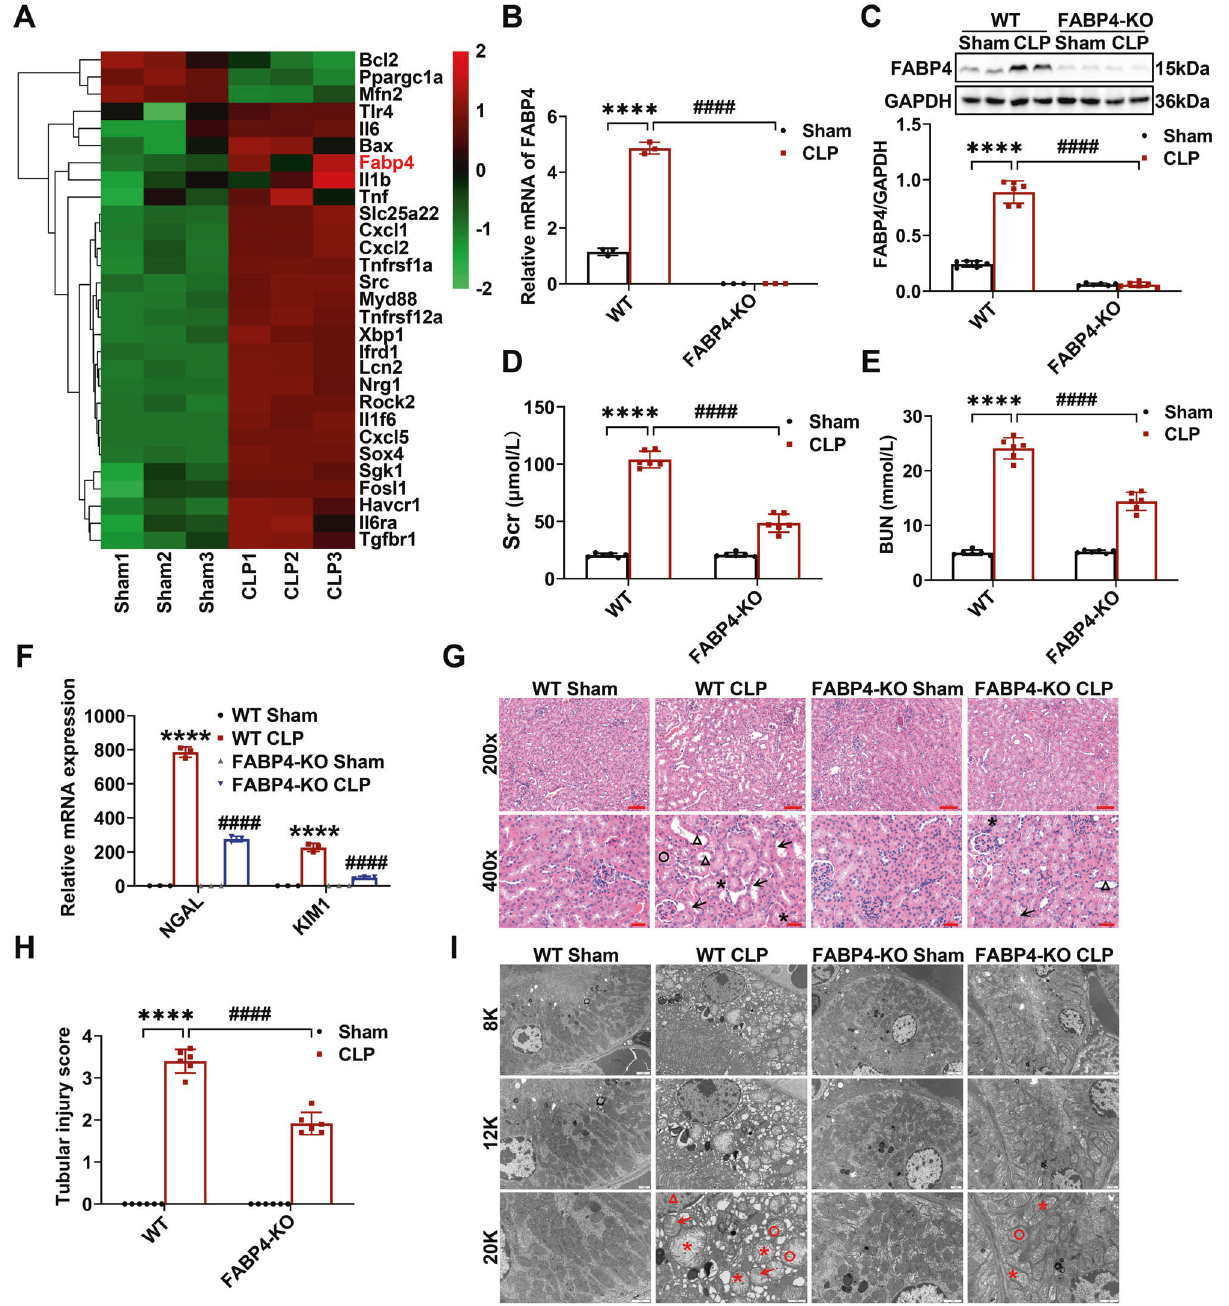
Fig. 1 FABP4 de fi ciency ameliorated CLP-induced septic AKI in mice. C57BL/6J, FABP4 KO, and WT mice (male, 8 – 10 weeks old) were subjected to CLP or sham surgery and killed 16 h later. A Representative heatmap of differentially expressed genes in the kidneys of C57BL/6J mice between sham and CLP group ( n = 3). B Quantitative real-time PCR analysis of FABP4 in kidney tissues ( n = 3). C Western blotting of FABP4 and quanti fi cation by densitometry normalized with GAPDH in the kidneys ( n = 6). D Serum creatinine (Scr) and ( E ) BUN in different groups of mice ( n = 6). F Quantitative real-time PCR analysis of NGAL and KIM1 in kidney tissues ( n = 3). G Representative HE staining micrographs (×200, scale bar = 50 μ m; ×400, scale bar = 20 μ m) and ( H ) tubular injury scores of kidney tissues ( n = 6). Triangle: tubular dilatation; Asterisk: tubular swelling; Circle: cast formation; Arrow: loss of brush border. I Representative subcellular structures of renal tubular epithelial cells (RTECs) from different groups of mice collected by transmission electron microscope (TEM) (×8000, scale bar = 2 μ m; ×12,000, scale bar = 1 μ m; ×20,000, scale bar = 1 μ m). Triangle: chromosome condensation; Asterisk: mitochondrial swelling; Circle: mitochondrial cristate fused; Arrow: mitochondrial cristate disappeared. All data are represented as mean ± SD; **** P < 0.0001, versus WT Sham; #### P < 0.0001, versus WT Statistical analysis buffer, and fi nally stained with 5 μ l Annexin V-FITC and 5 μ l propidium The random number table method was used for random allocation. All iodide (PI) in dark for 15 min at room temperature. At last, apoptotic cells experiments were repeated at least three times. Data were represented as were analyzed by a fl ow cytometer (Beckman Cyto fl ex, Beckman Coulter mean ± SD. The number of biological replicates was presented by Australia Pty Ltd., Lane Cove, NSW, Australia).